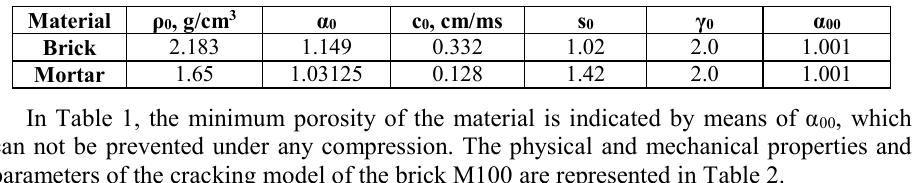
Table 1. Parameters of the constitutive equation.